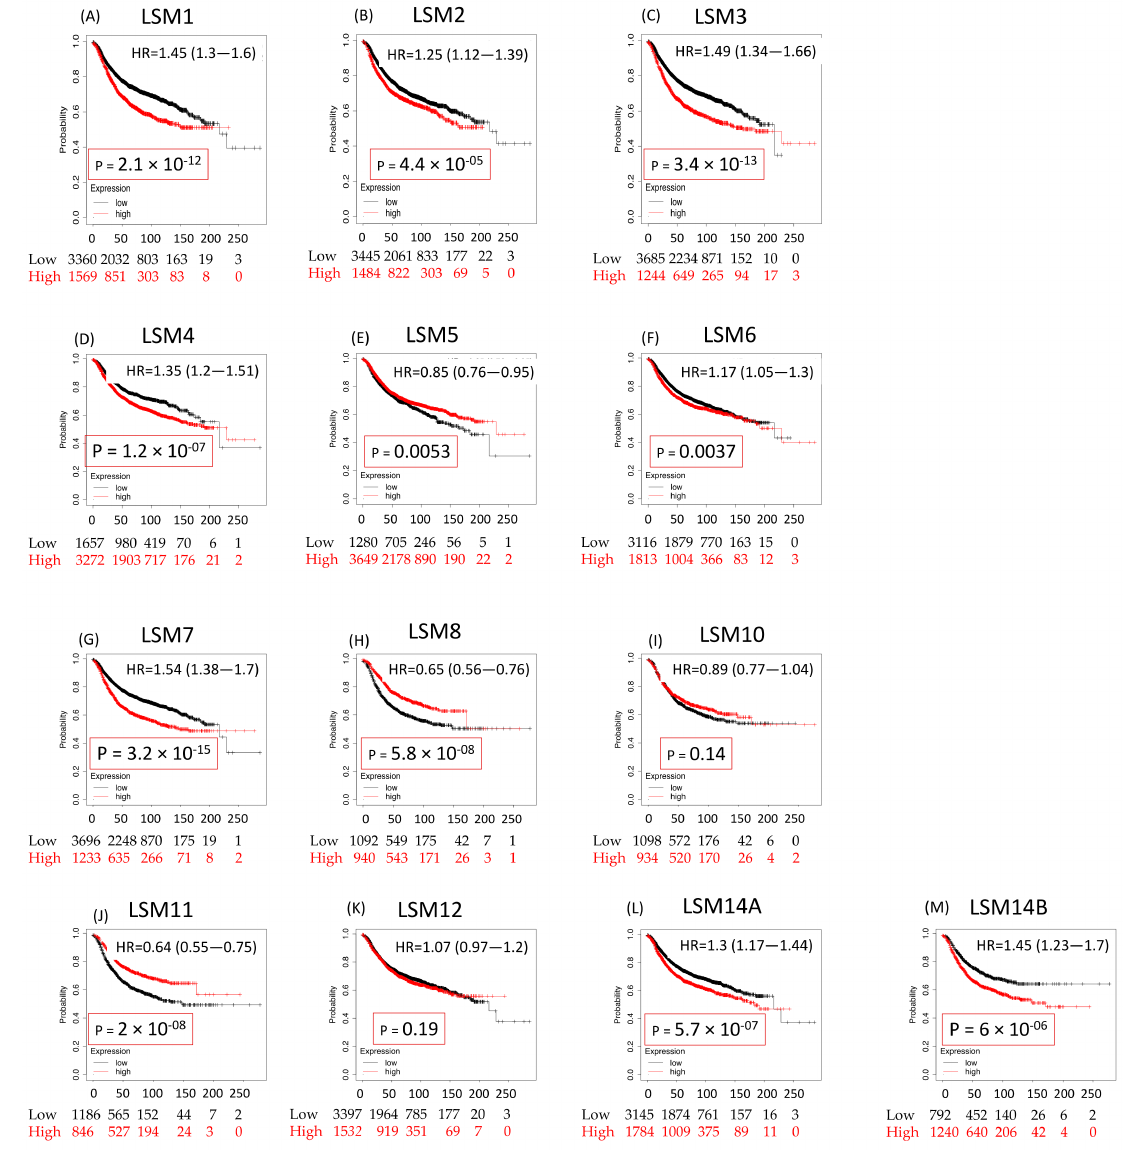
Figure 3. Prognostic value of LSM family genes in breast cancer patients. A recurrence-free survival (RFS) dataset was used for analysis ( n = 4929 patients). An auto-cutoff strategy was set in this analysis to differentiate patients into two groups based on the value of LSM mRNAs. The best JetSet probes, which describe LSMs, were used to map Affymetrix probe sets by choosing the best probe set for this analysis. Higher expression levels are shown in red, whereas lower expression values are in black. Results showed correlations between expressions of LSMs and survival outcomes of breast cancer patients. By splitting patients by the median, only the best probe Jetset and auto-cutoff were queried. The results indicated that LSM1/2/3/4/5/6/7/14A/14B were significantly associated with poor prognostic outcome of breast cancer